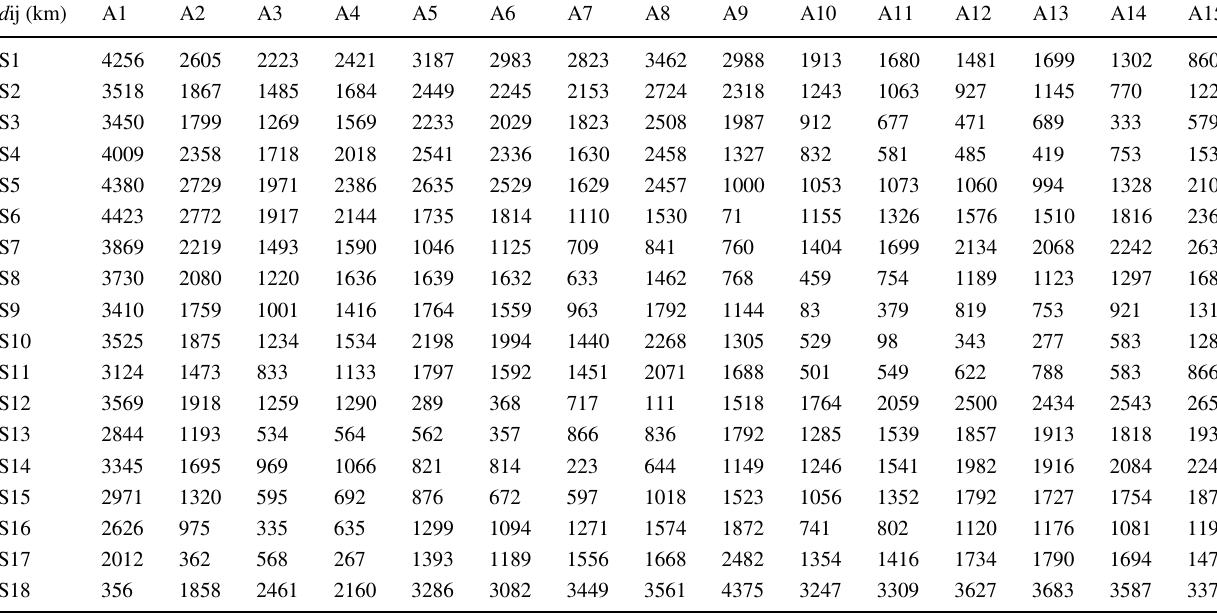
Table 8 The shortest distance from alternative points to potential disaster-affected